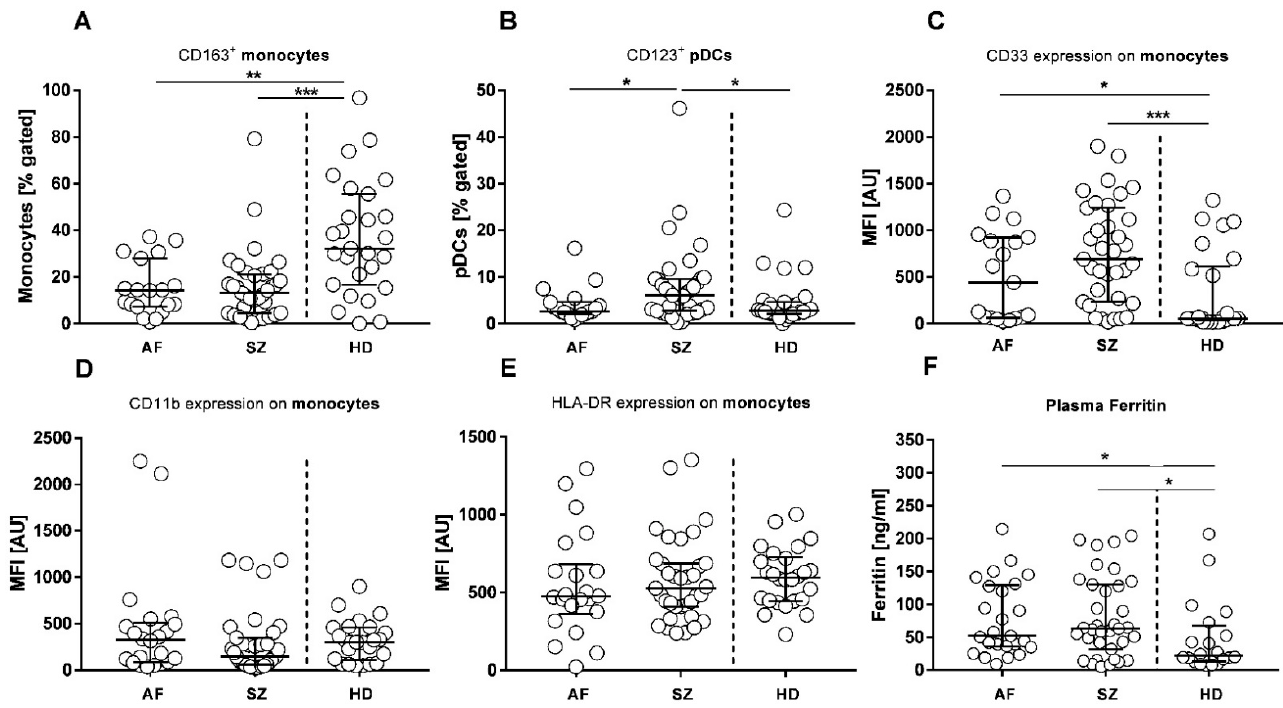
Figure 3. Flow cytometric profiles of antigen-presenting cells (APCs) in patients with AF, SZ, and HDs. Relative amounts (% gated) of CD163 + leukocytes (AF/HDs: median: 14.23 vs. 32.22, p = 0.001; SZ/HDs: median: 13.11 vs. 32.22, p ≤ 0.001) ( A ) and CD123 + pDCs (median: 6.060 vs. 2.650, p = 0.02 ( B ) are shown. Expression densities of CD33 (AF/HDs: median: 441.0 vs. 56.24, p = 0.03; SZ/HDs: median: 691.2 vs. 56.24, p ≤ 0.001) ( C ), CD11b ( D ) and HLA-DR ( E ) are shown and given as arbitrary units (AU). Ferritin plasma concentrations: (AF/HDs: median: 52.00 ng/mL vs. 22.20 ng/mL, p = 0.02; SZ/HDs: median: 62.80 ng/mL vs. 22.20 ng/mL, p = 0.04) are shown in ( F ). All results